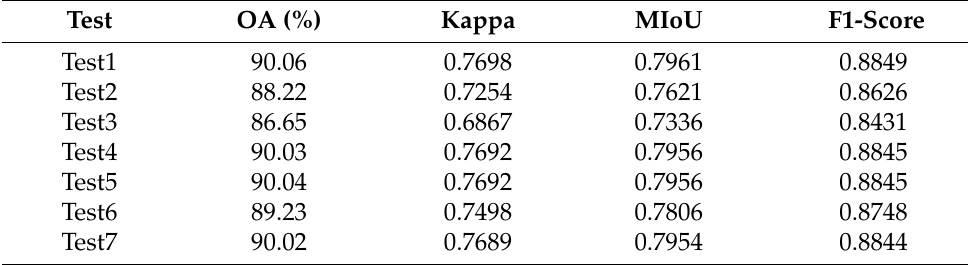
Table 9. Impervious surface extraction accuracies of HRNet with different feature